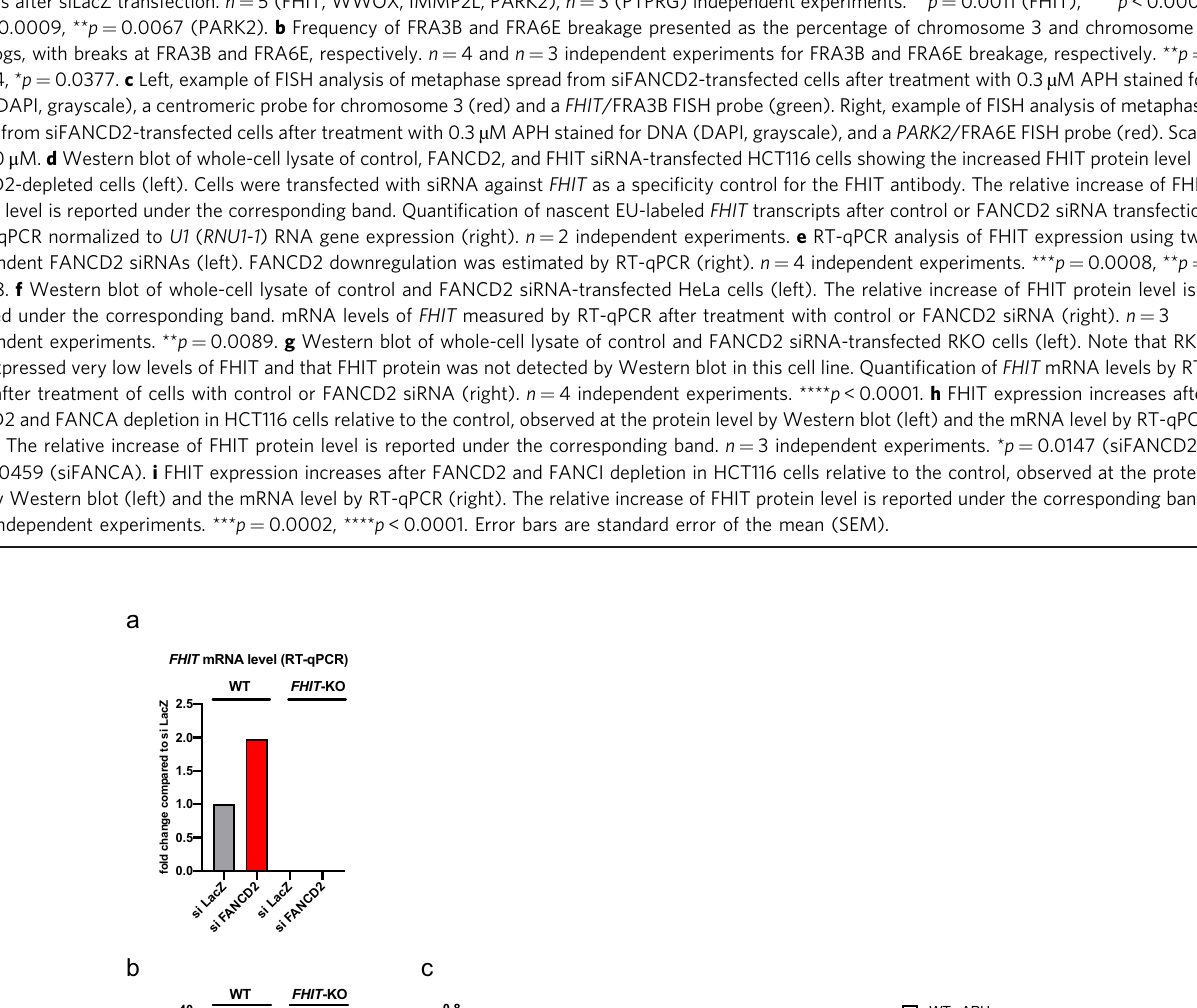
Fig. 1 FANCD2 depletion induces CFS gene expression. a mRNA levels of large CFS genes measured by RT-qPCR after siFANCD2 transfection, compared to levels after siLacZ transfection. n = 5 (FHIT, WWOX, IMMP2L, PARK2), n = 3 (PTPRG) independent experiments. ** p = 0.0011 (FHIT), **** p < 0.0001,